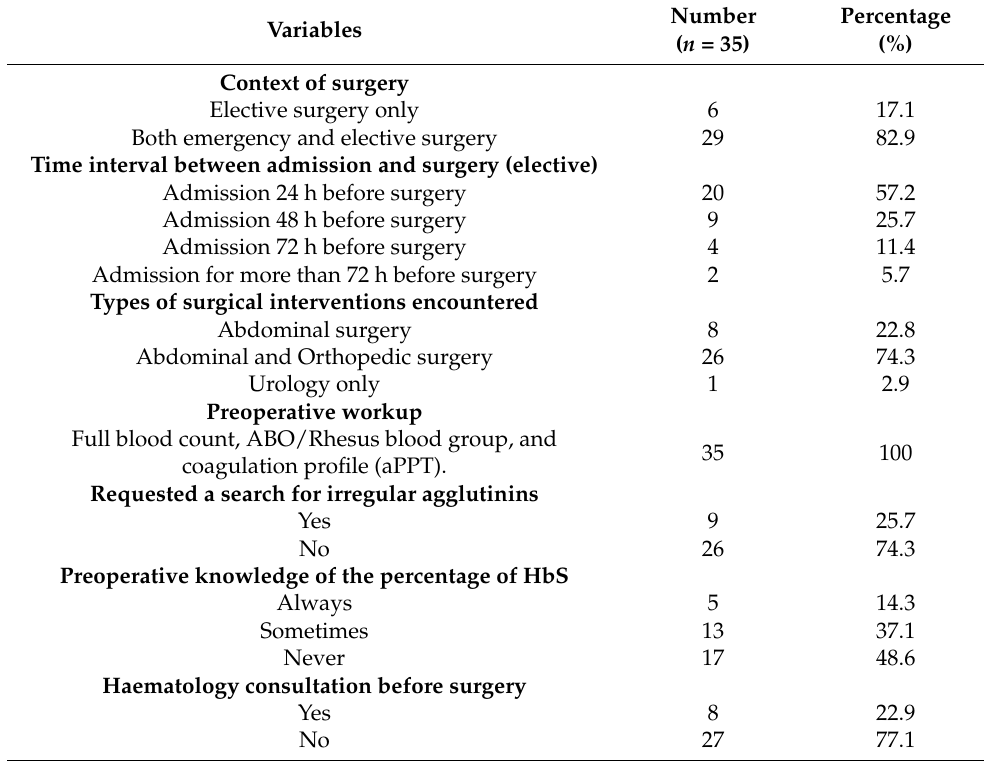
Table 2. Preoperative management of patients with sickle cell disease by